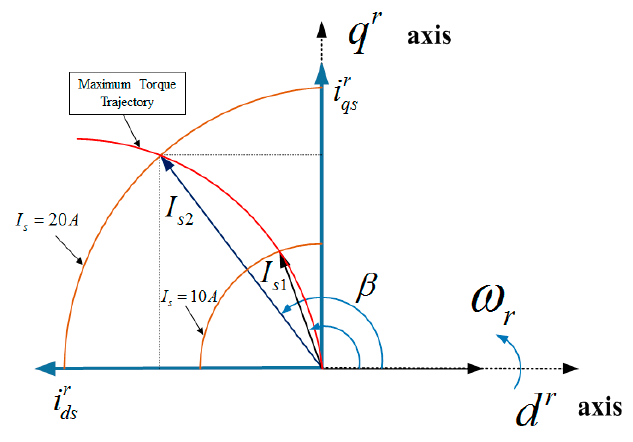
Figure 6. Example of d–q axis current control reference. Table 2. Maximum torque points according to the input stator current